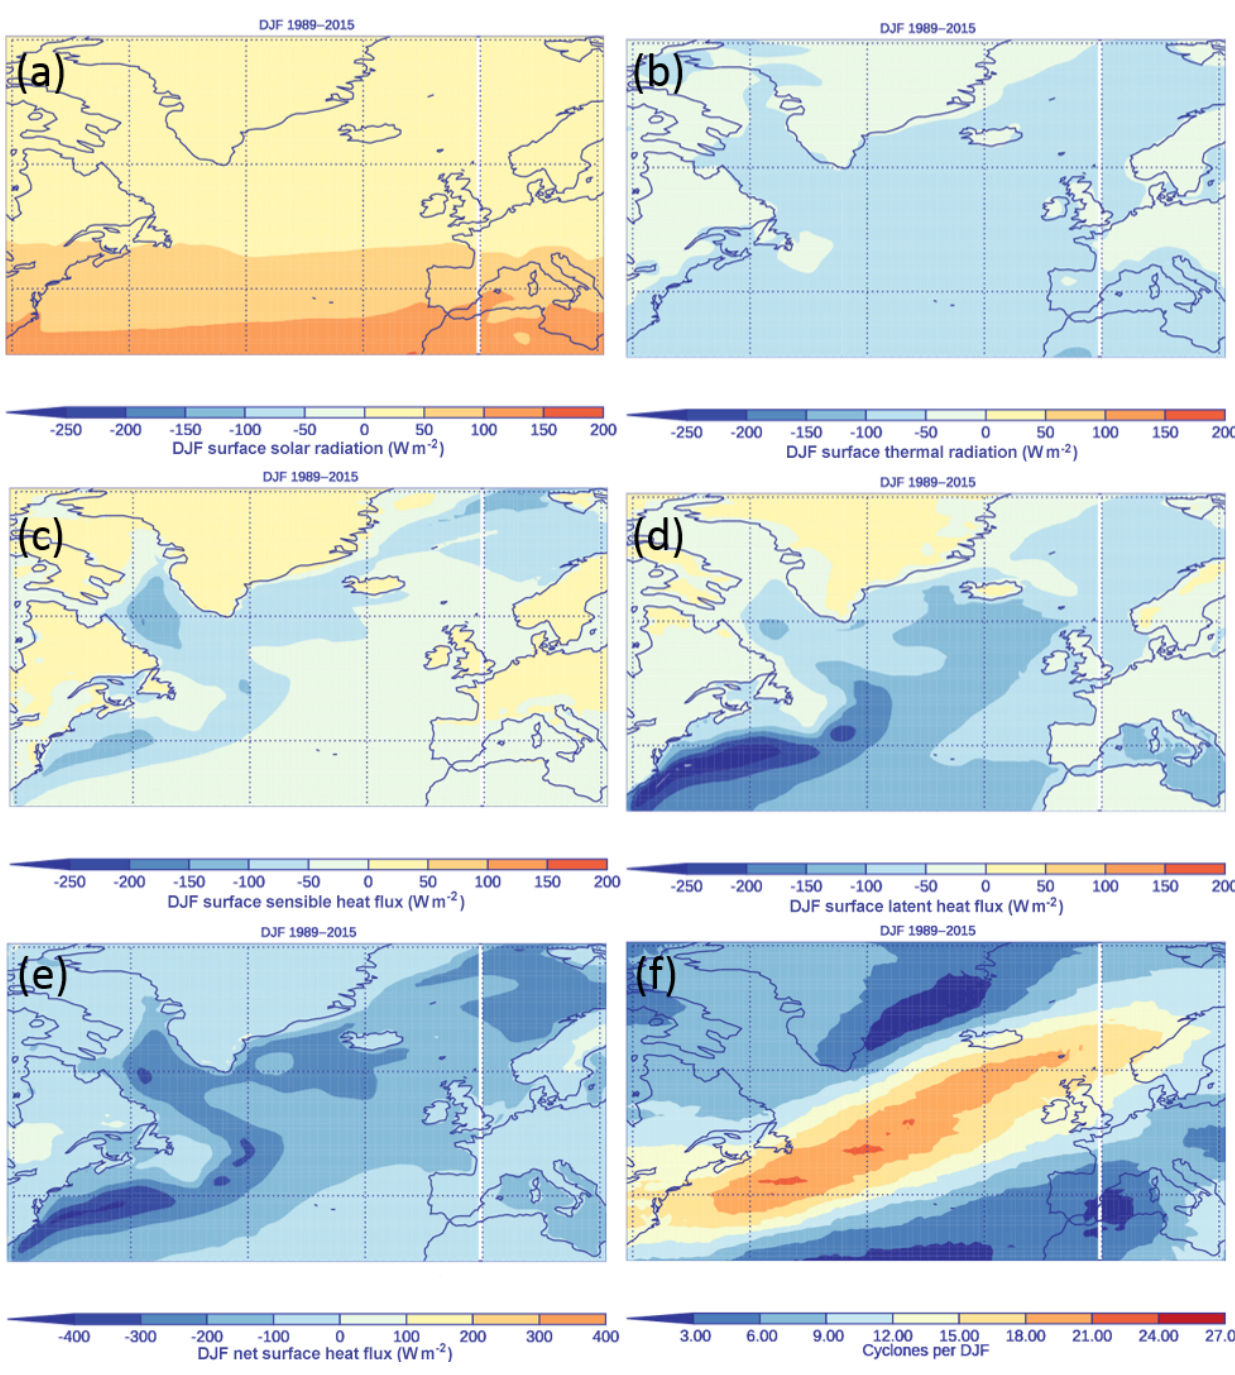
Figure 3. North Atlantic 1989–2015 heat flux climatologies (Wm − 2 ). (a) Surface solar radiation Q SW , (b) surface thermal radiation Q LW , (c) surface sensible heat flux Q H , (d) surface latent heat flux Q E and (e) net surface heat flux Q N . Note change in scale in (e) . Positive flux is into the surface, and negative flux is into the atmosphere. (f) 1989–2015 climatological number of cyclones per DJF season within 12 ◦ of grid